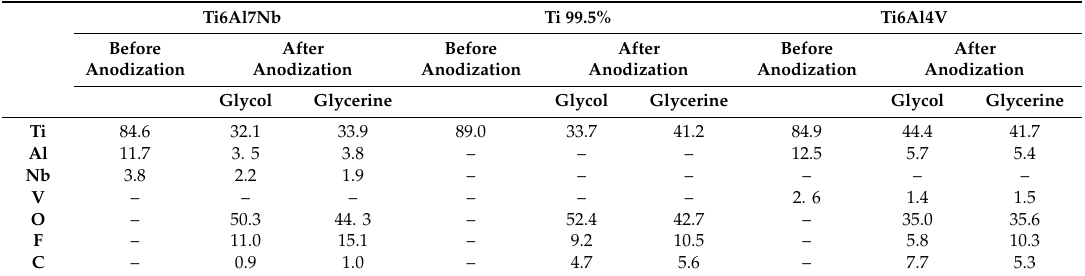
Table 2. Chemical composition (at%) of tested alloys before and after anodization in glycol- and glycerine-based electrolyte measured by the EDS method. Ti6Al7Nb Ti 99.5% Ti6Al4V Before After Before After Before After Anodization Anodization Anodization Anodization Anodization Anodization Glycol Glycerine Glycol Glycerine Glycol